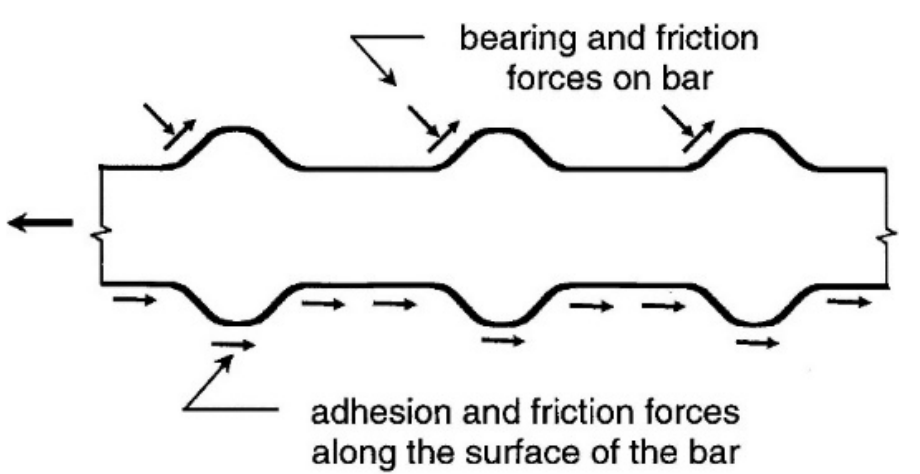
Figure 1. Bond force transfer mechanisms [2].